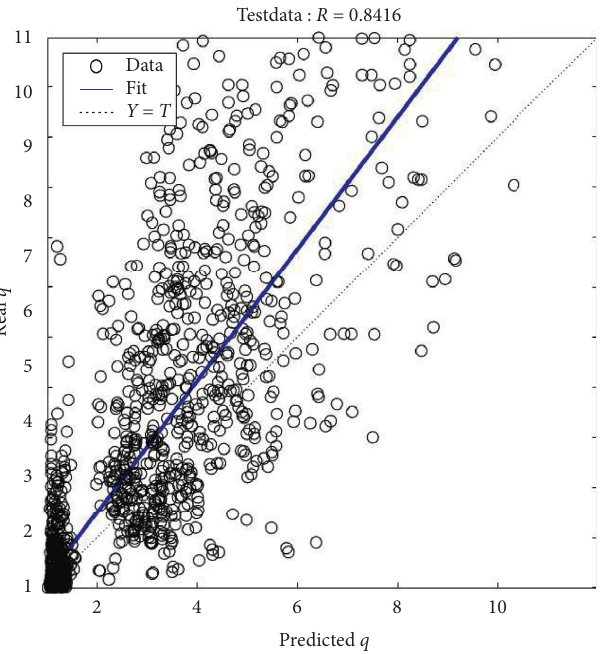
, λ , α ,T , and μ ) and predicted q (training data). s p R